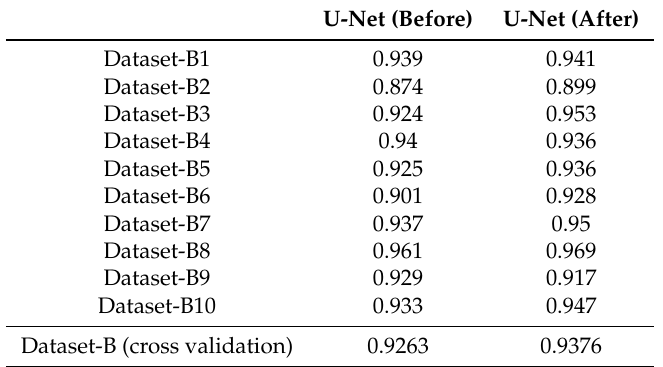
Table 15. IoU tested on Dataset-B using U-Net before and after using the chosen configurations. U-Net (Before) U-Net (After)